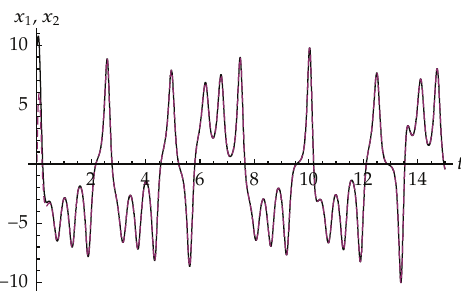
Figure 12: Synchronized signals x 1 ; x 2 (cid:3) α (cid:8) 0 . 99 (cid:4) .